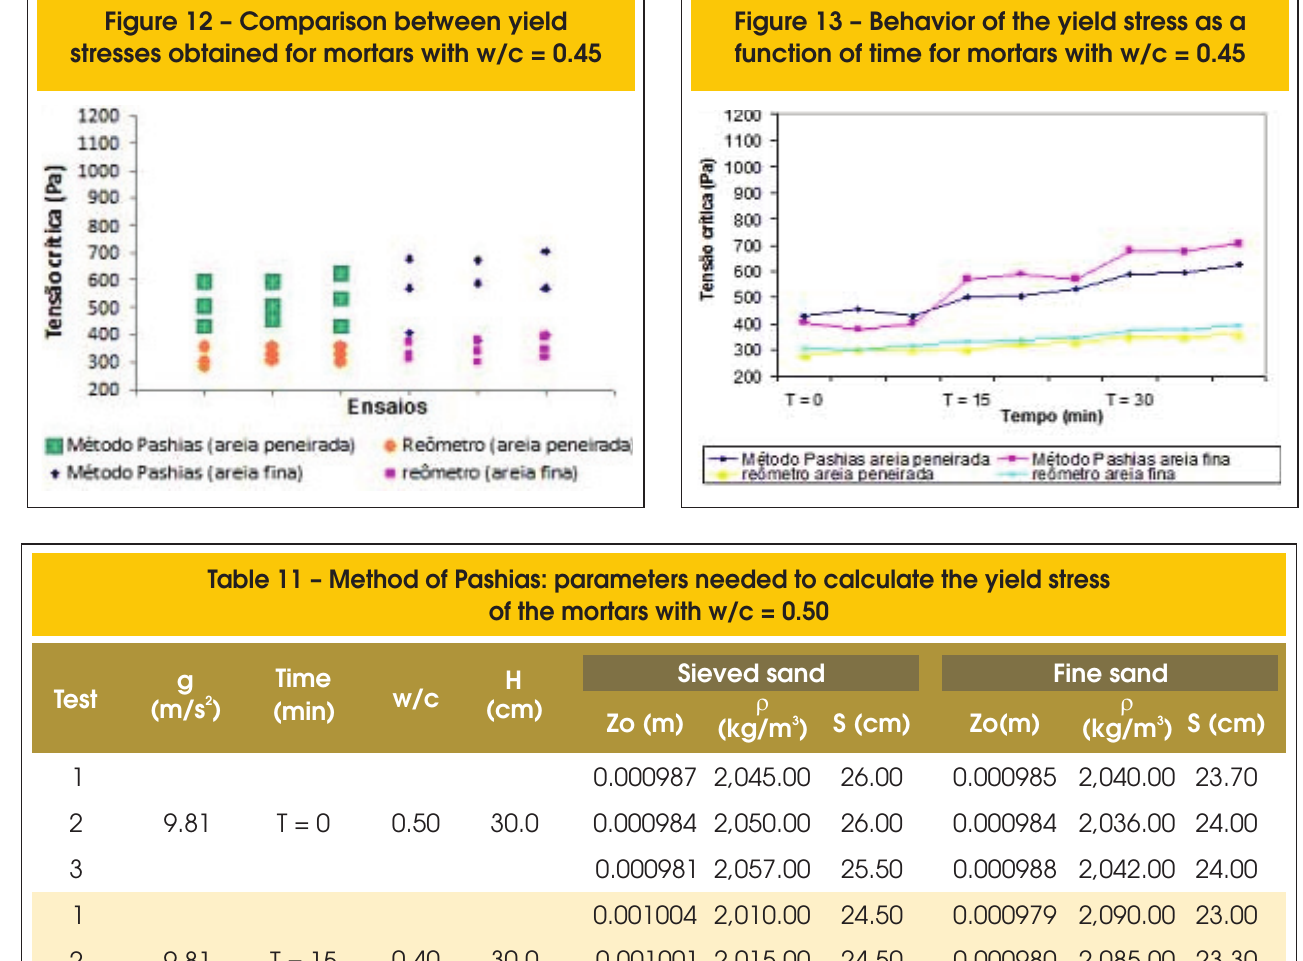
Figure 12 – Comparison between yield stresses obtained for mortars with w/c = 0.45